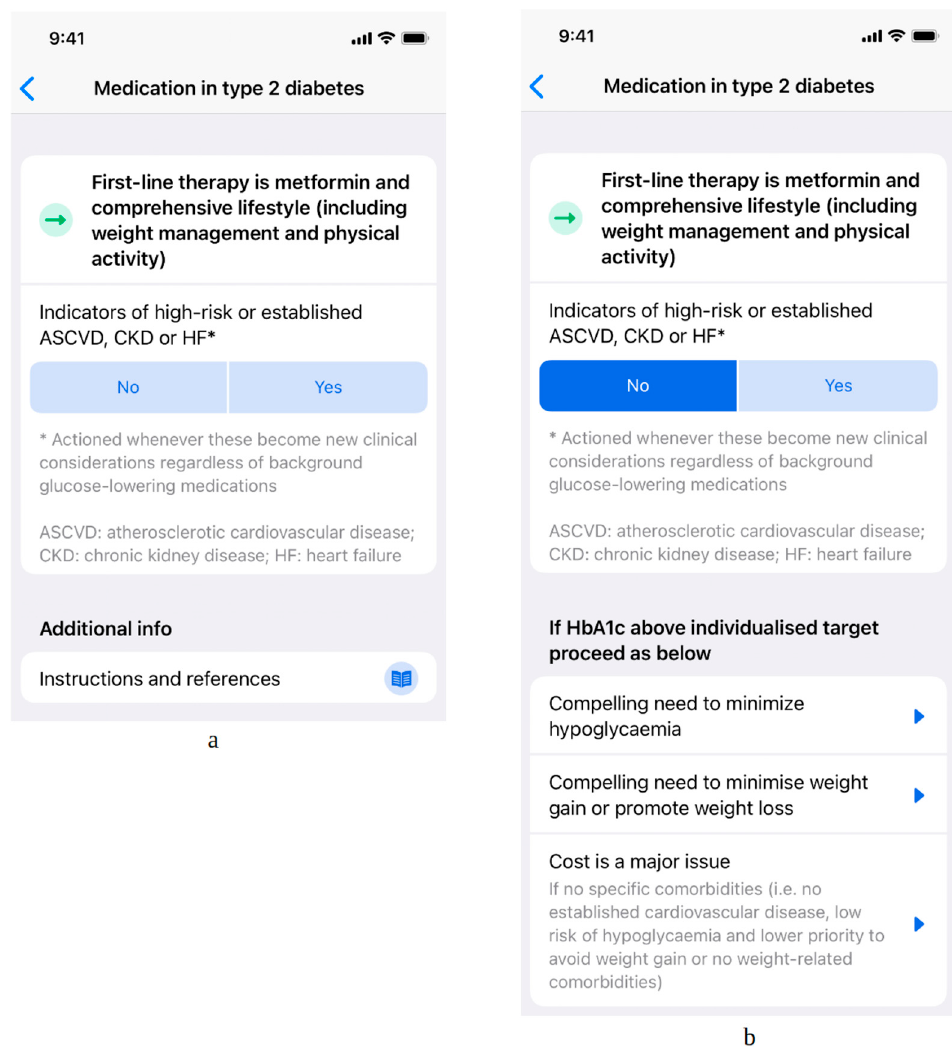
Figure 1. An illustrative usage scenario: ( a ) first-line therapy is suggested to the user, along with additional information in order to make a comorbidity-based treatment individualization; ( b ) dif- ferent options for treatment individualization are suggested to the user, based on the presence or absence of specific comorbidities; additional information takes into account other concomitant fac- tors, such as minimization of hypoglycemia, promotion of weight loss, and cost as a major issue. HbA1c: hemoglobin A1C (glycated hemoglobin)